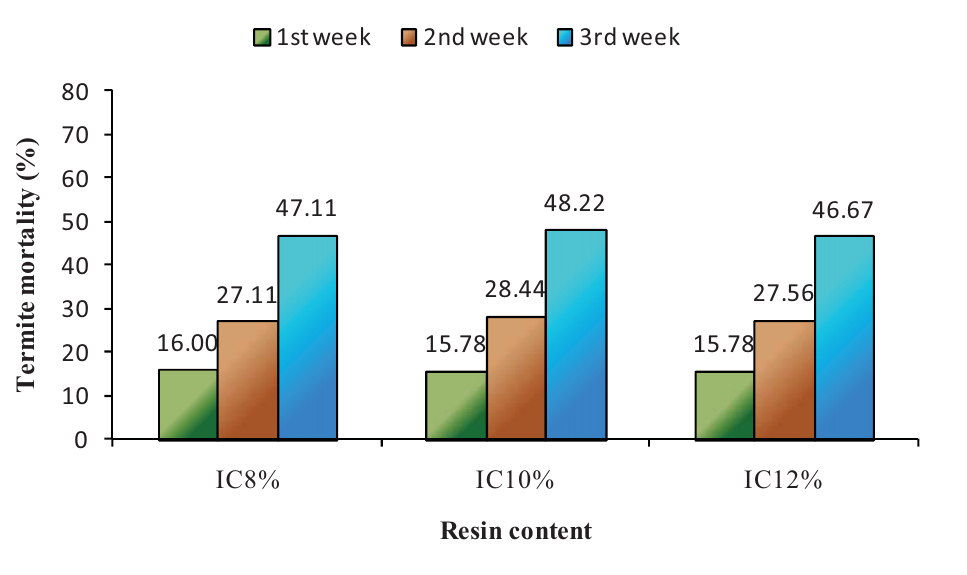
Figure 4. Weekly termite mortality on bare sisal fiberboards at three isocyanate contents.